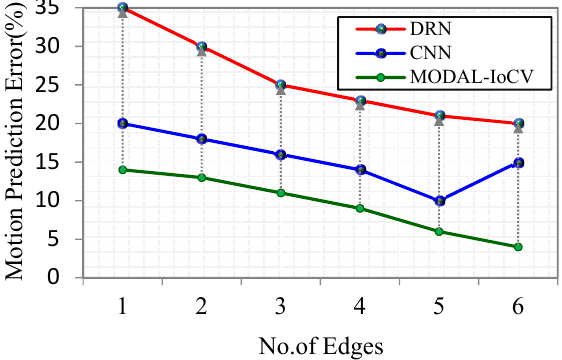
Figure 8. Number of edges vs. motion prediction error.